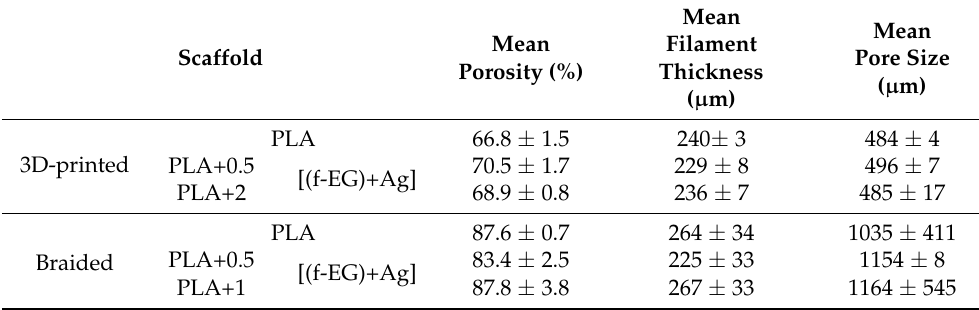
Figure 5. Morphology of the surface of the ( a ) 3D-printed scaffold containing PLA+2[(f-EG)+Ag], and ( b ) braided scaffold with PLA+1[(f-EG)+Ag].